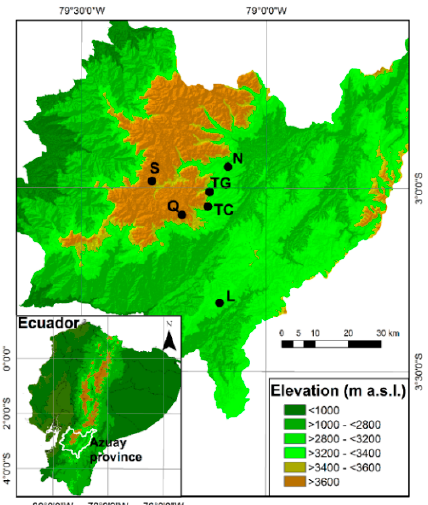
Figure 1. Location map of the study area showing the sites that correspond to natural grassland and pine plantations in three different elevational ranges: N (Nero) and L (La Paz) from 3200 to 3400 m a.s.l., TC (Tutupali Chico) and TG (Tutupali Grande) from 3400 to 3600 m a.s.l. and Q (Quimsacocha) and S (Soldados) from 3600 to 3800 m a.s.l.